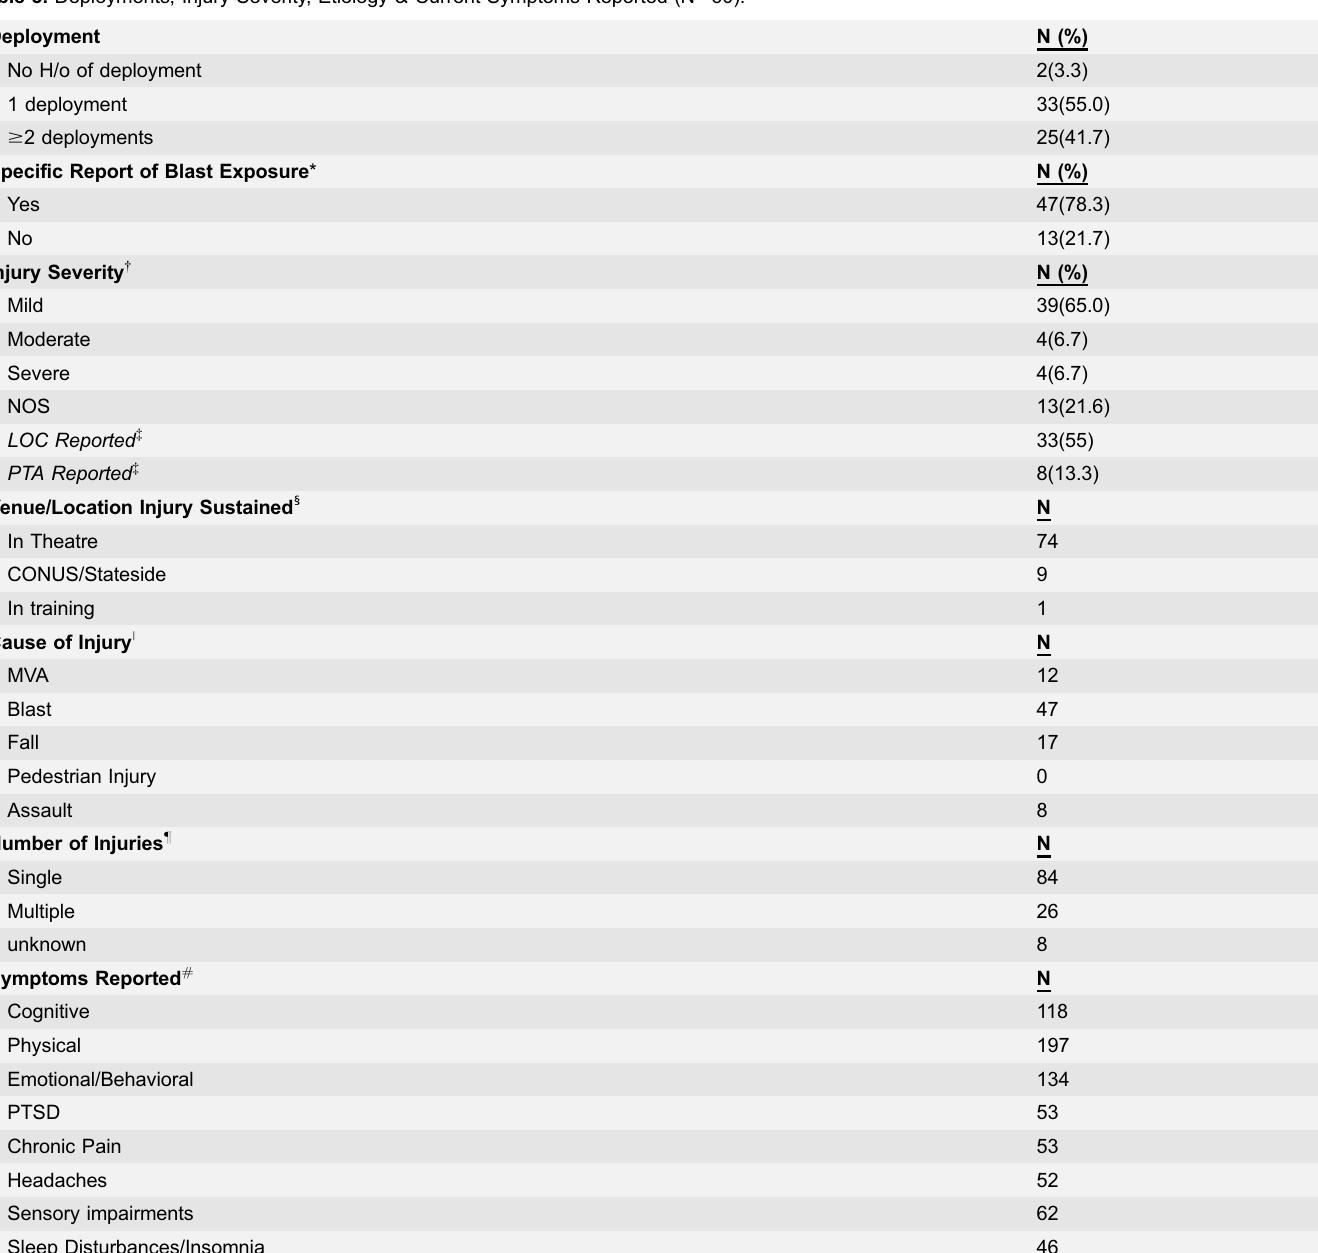
Table 3. Deployments, Injury Severity, Etiology & Current Symptoms Reported (N 5